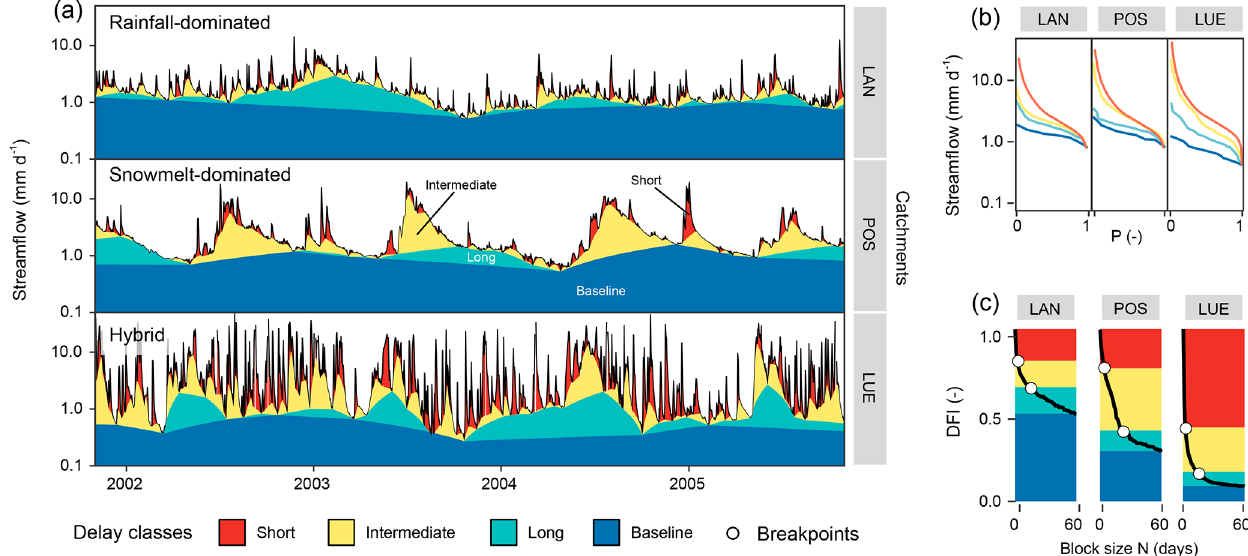
Figure 1. (a) Delayed-flow separation for three catchments from Switzerland, namely Langeten (LAN), Poschiavino (POS) and Lümpe- nenbach (LUE), with different streamflow regimes; (b) flow duration curves for delayed-flow hydrographs (for 1d, at breakpoint 1, at breakpoint 2 and for 60d); and (c) DFI N values for different block size N values shown in combination with breakpoints (circles). Colours refer to the four different delay classes identified. The methodology to derive the breakpoints and delay classes is explained in Sect. 2.3. The catchment classification is explained in Table 1 in Sect. 3. Note the logarithmic y axis in (a) and (b)